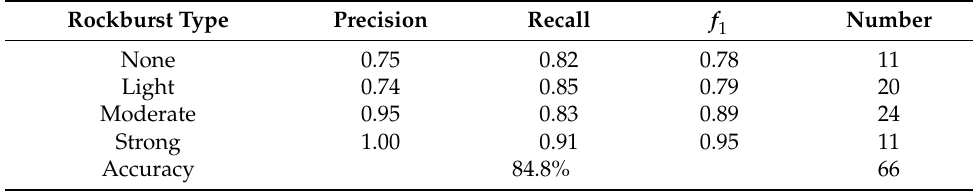
Table 11. The testing performance of the RF model.